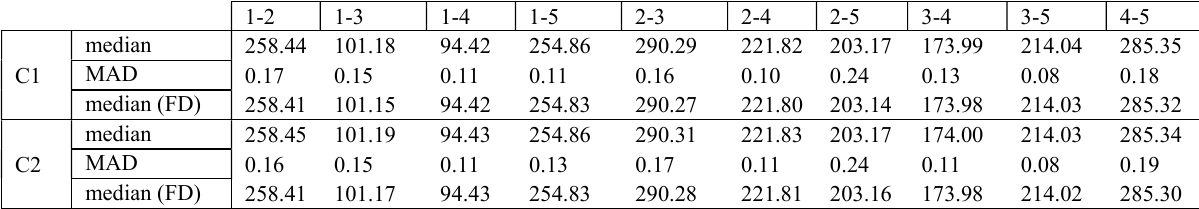
Table 1. Estimated baselines obtained from calibration 1 before the acquisition (C1) and calibration 2 after the acquisition (C2). The table reports the median and MAD of the whole dataset and the median of the filtered dataset (FD) after outlier removal. All values are expressed in millimetres.